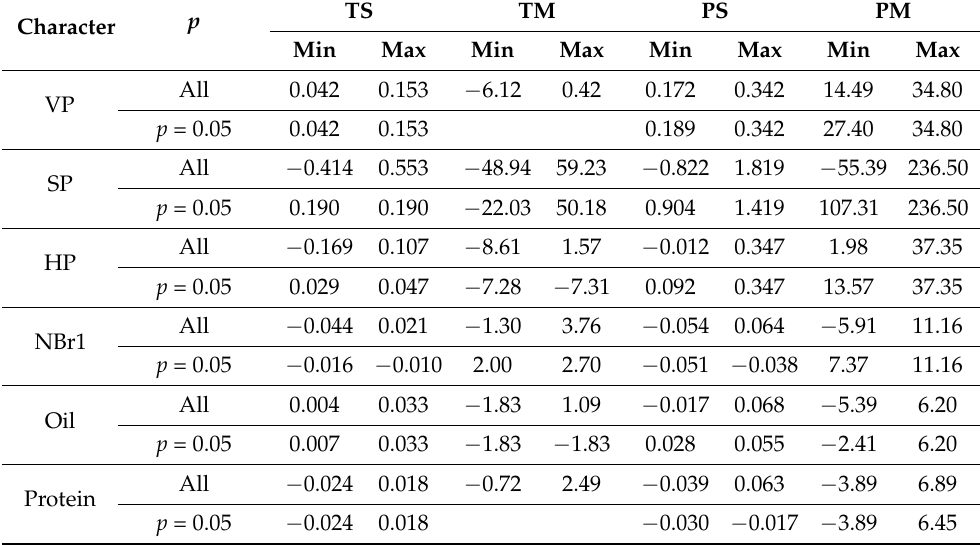
Table 6. Range of variability of regression coefficients “character × environmental